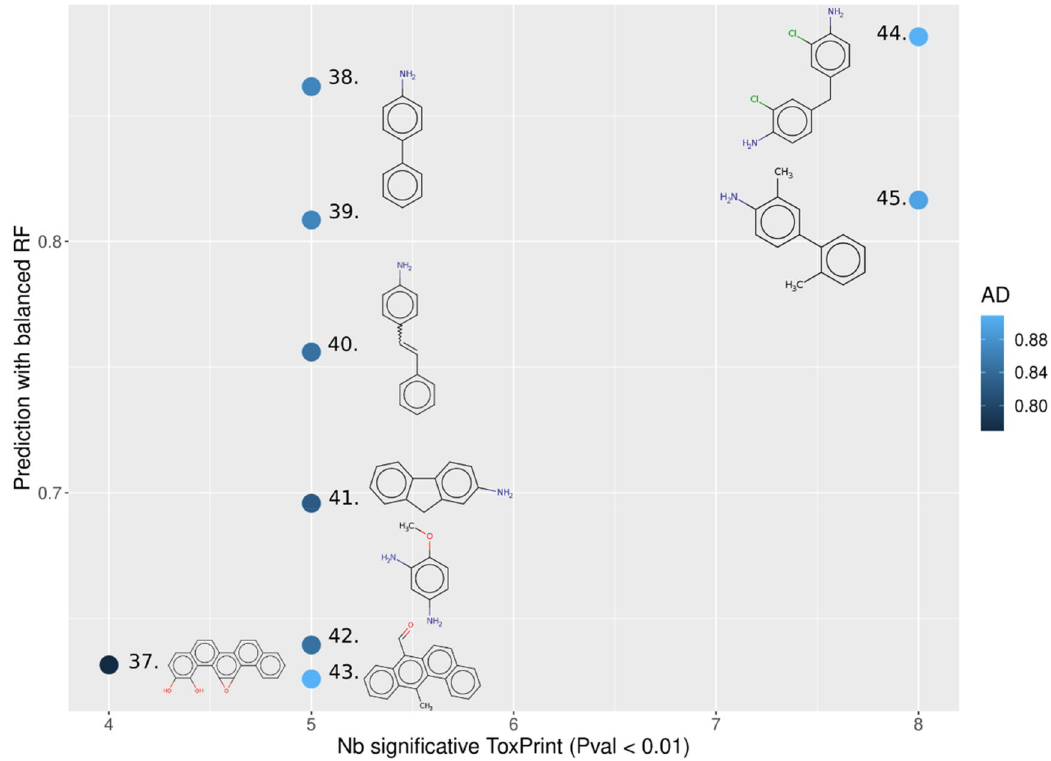
Figure 12. Predicted E2up chemicals from the MC set of chemicals. The x-axis represents the number of ToxPrints significant for E2up, the y-axis represents the probability prediction to be E2up, and the applicability model is in blue (minimal similarity score with the first chemicals in the training set). Chemical structures are represented in the figure: 37. anti-benzo[a]chrysene-11,12-diol-13,14-epoxide (132,832–26–9), 38. 4-biphenylamine (92–67–1), 39. p-aminobiphenyl hydrochloride (2113–61–3), 40. 4-aminostilbene (834– 24–2), 41. 2-aminofluorene (153–78–6), 42. 2,4-diaminoanisole sulfate (39,156–41-7), 43. 12-methylbenz(a) anthracene-7-carboxaldehyde (13,345–61–4), 44. 4,4 ′ -methylenebis(2-chloroaniline) (101–14–4) and 45. 3,2 ′ -dimethyl-4-aminobiphenyl